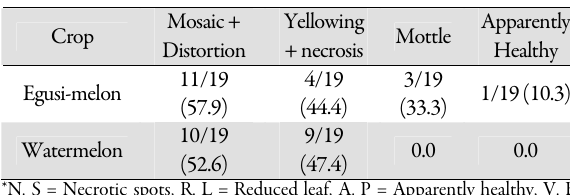
Tab. 3. Distribution of virus symptoms on cucurbit crops grown in Osun state in June